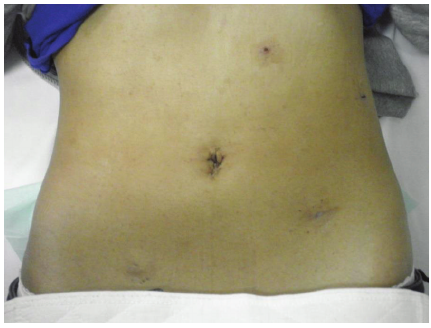
Figure 4: Postoperative